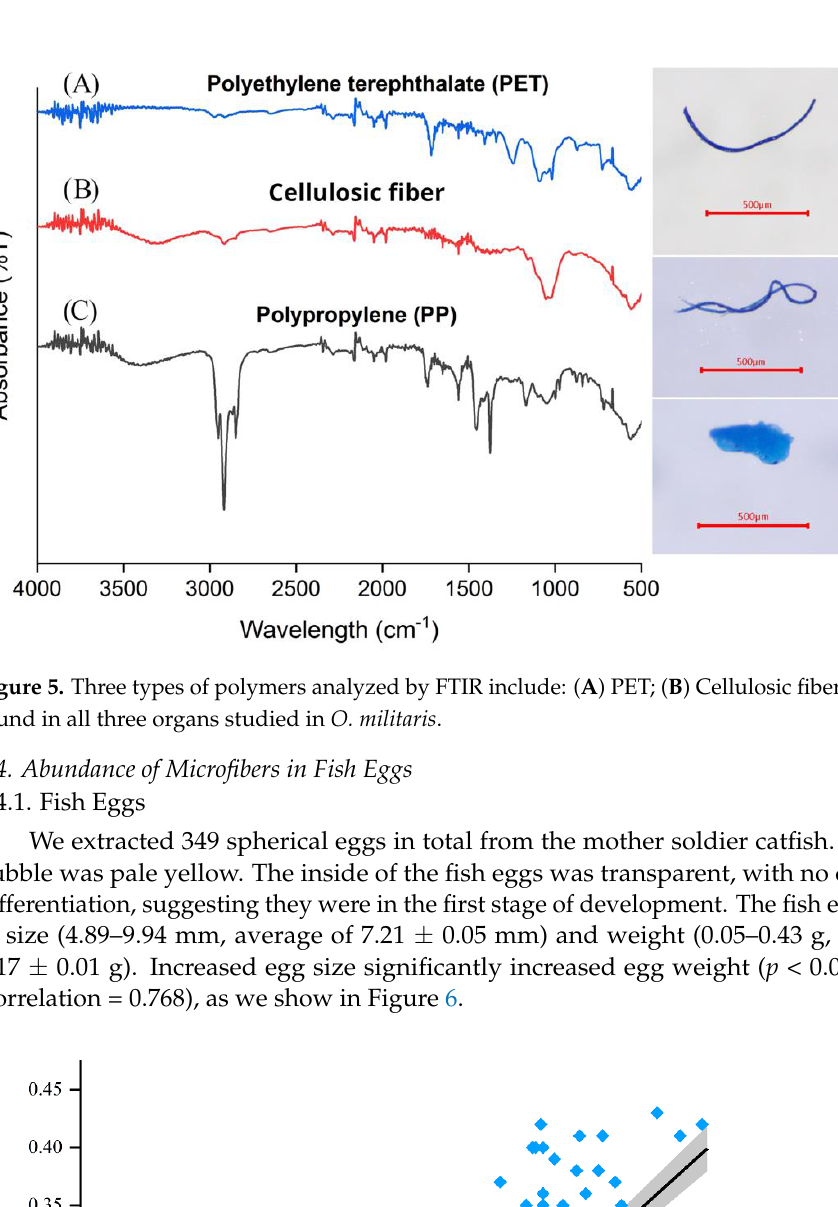
Figure 4 . The percentage of polymer type found in each organ studied in O . militaris .